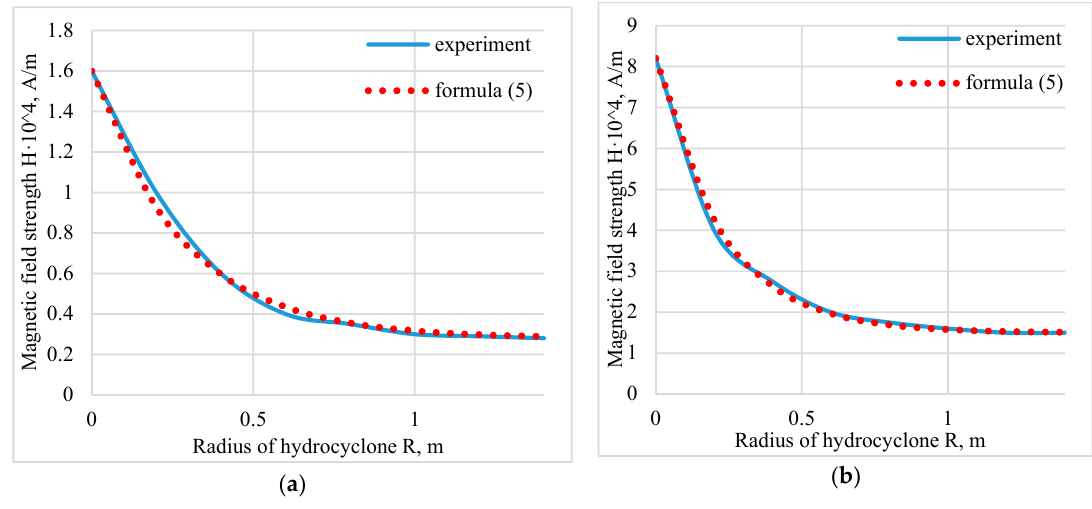
( b ) Figure 4. Change in magnetic field strength along the radius at various currents in the winding: ( а ) I = 1 А , n 1 = 4; ( b ) I = 8 А , n 1 = 5.7.